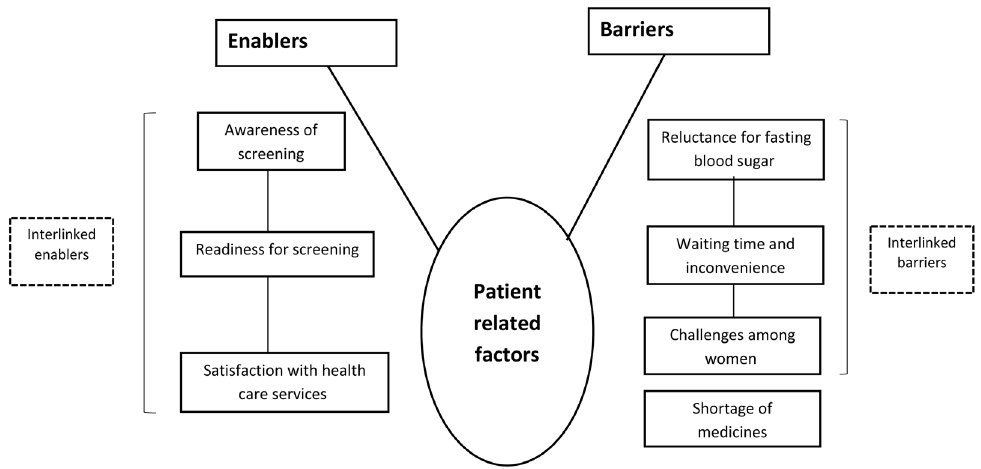
Figure 4. Non-hierarchical thematic map showing enablers and barriers in the implementation of opportunistic screening for diabetes mellitus and/or hypertension, as perceived by persons aged ≥ 30 years who underwent screening in two primary healthcare centres from March to May,